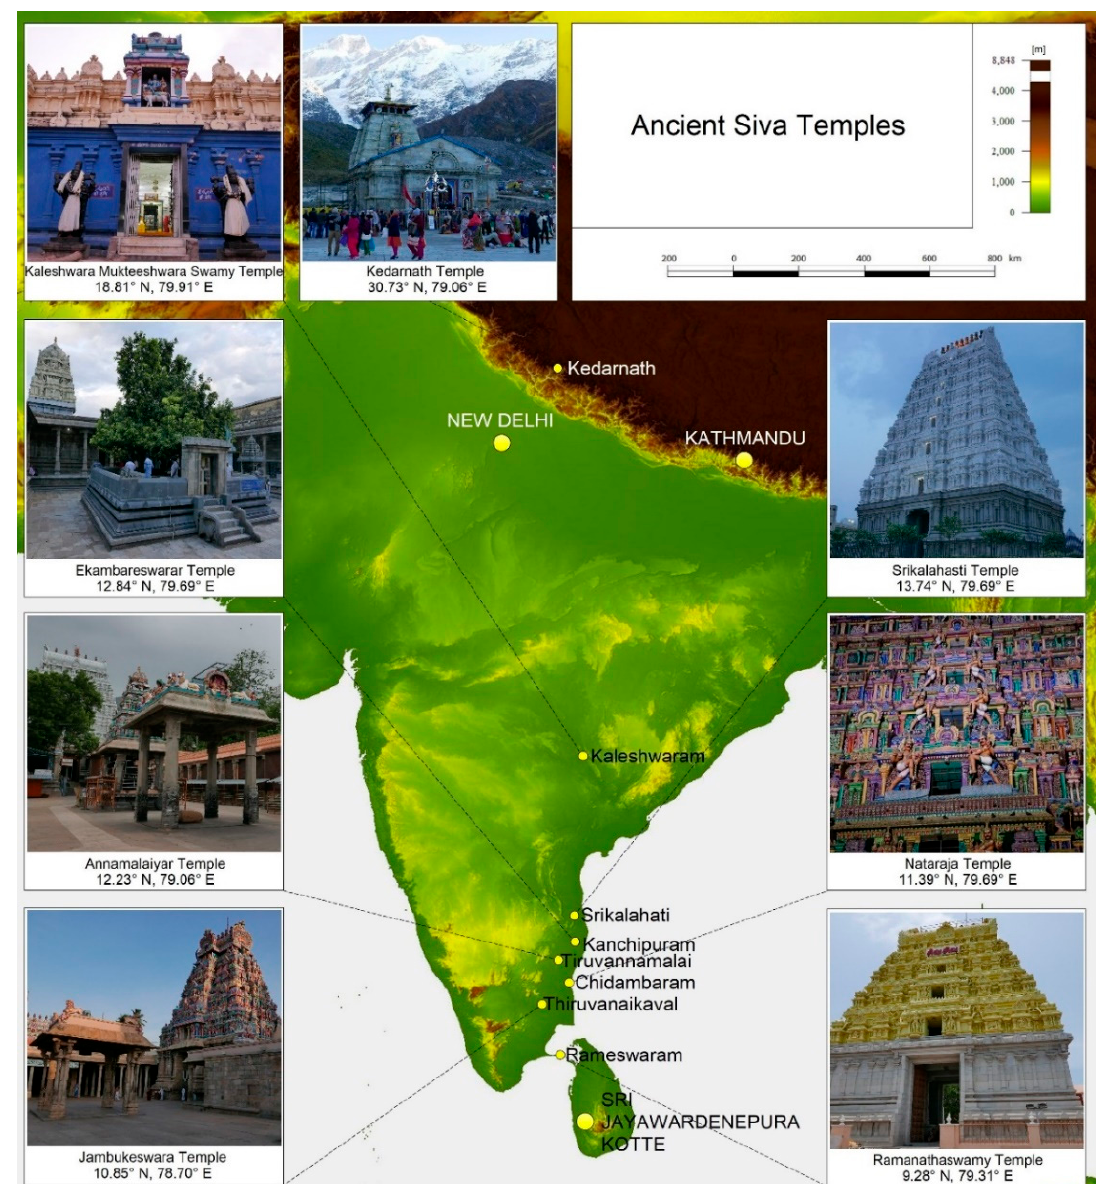
Figure 1. Location of ancient Shiva temples used for the field study.